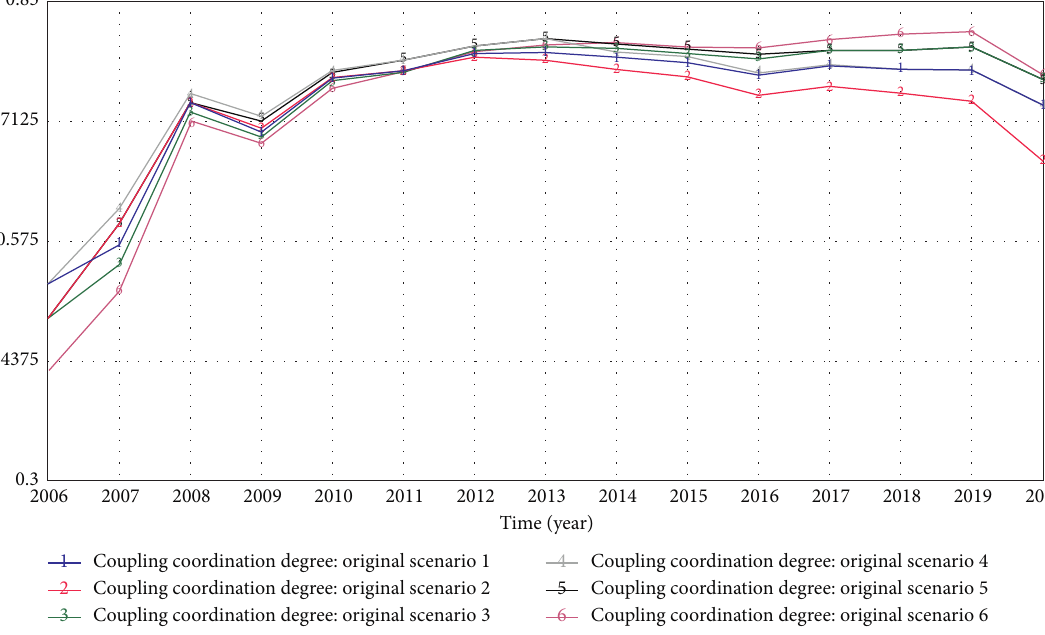
Figure 8: Green low-carbon development level of coal enterprises under Scenarios 1 to 6.